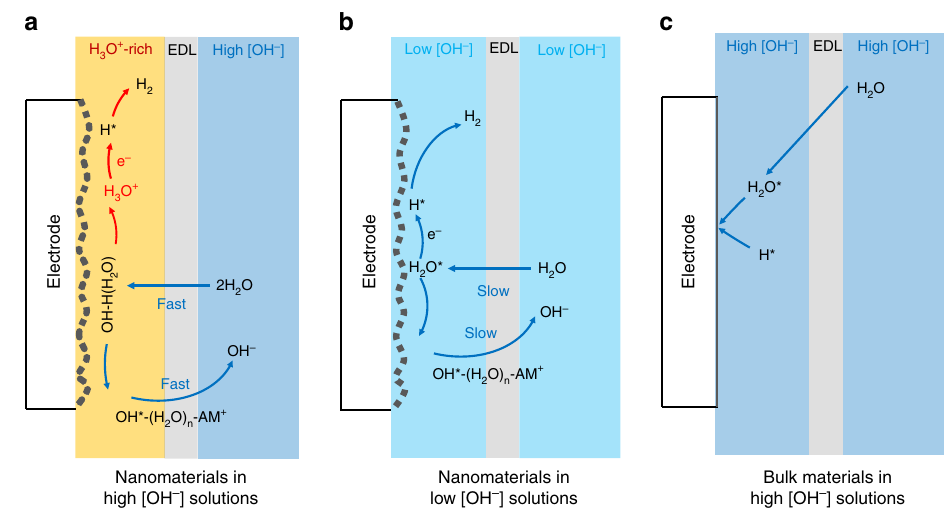
Fig. 6 Schematic illustration of the water reduction mechanism on the nanostructured electrocatalysts. a Surface intermediates on the nanostructured electrocatalysts in solutions with high [OH − ]. b Surface intermediates on the nanostructured electrocatalysts in solutions with low [OH − ]. c Water reduction mechanism on the bulk electrocatalysts in high-pH environments. EDL electric double